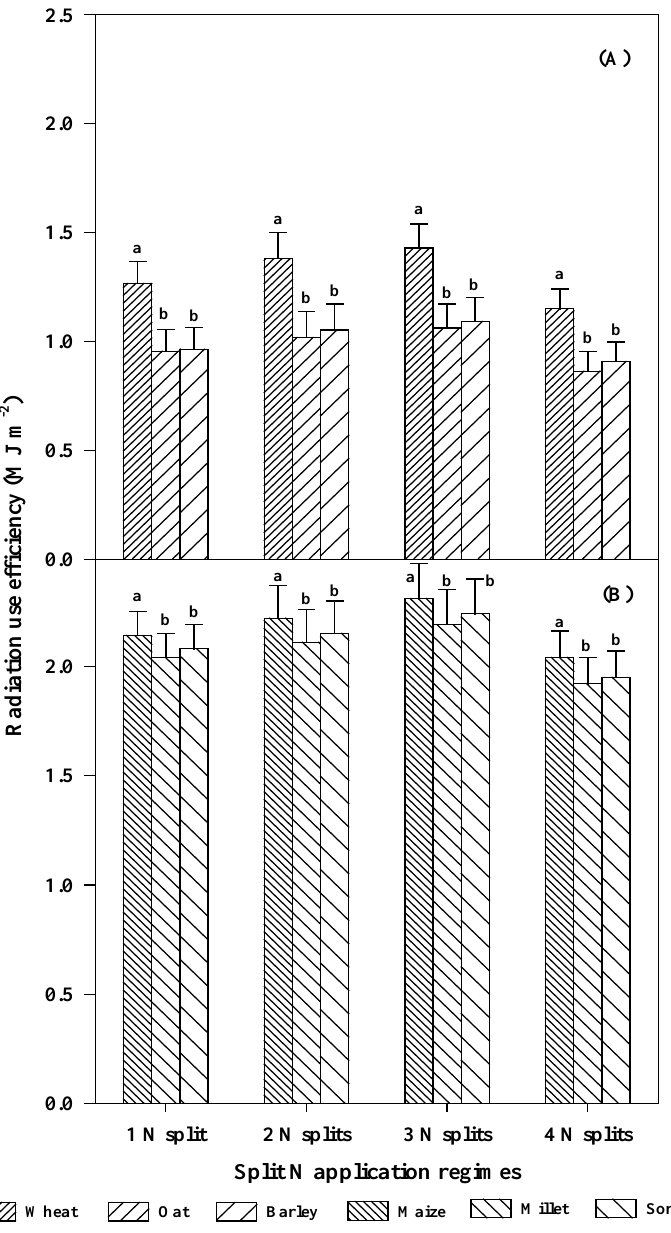
Figure 7. Radiation use efficiency of C 3 winter (( A ) wheat, oat, and barley) and C 4 summer (( B ) maize, millet, and sorghum) cereals under split N application regimes. Bars represent standard error.